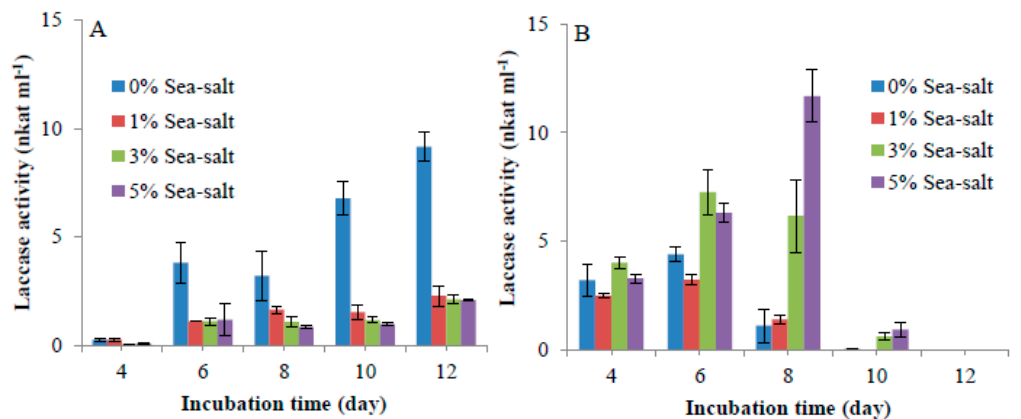
Figure 2. Laccase production in A. niger under saline conditions for Ps Lac1 ( A ) and Ps Lac2 ( B ). Laccase activities were determined on culture medium with 2,2’-azino-bis(3-ethylbenzothiazoline-6-sulphonic acid) (ABTS) as the substrate in standard conditions. Each data point (mean +/ − standard deviation) is the result of triplicate experiments.